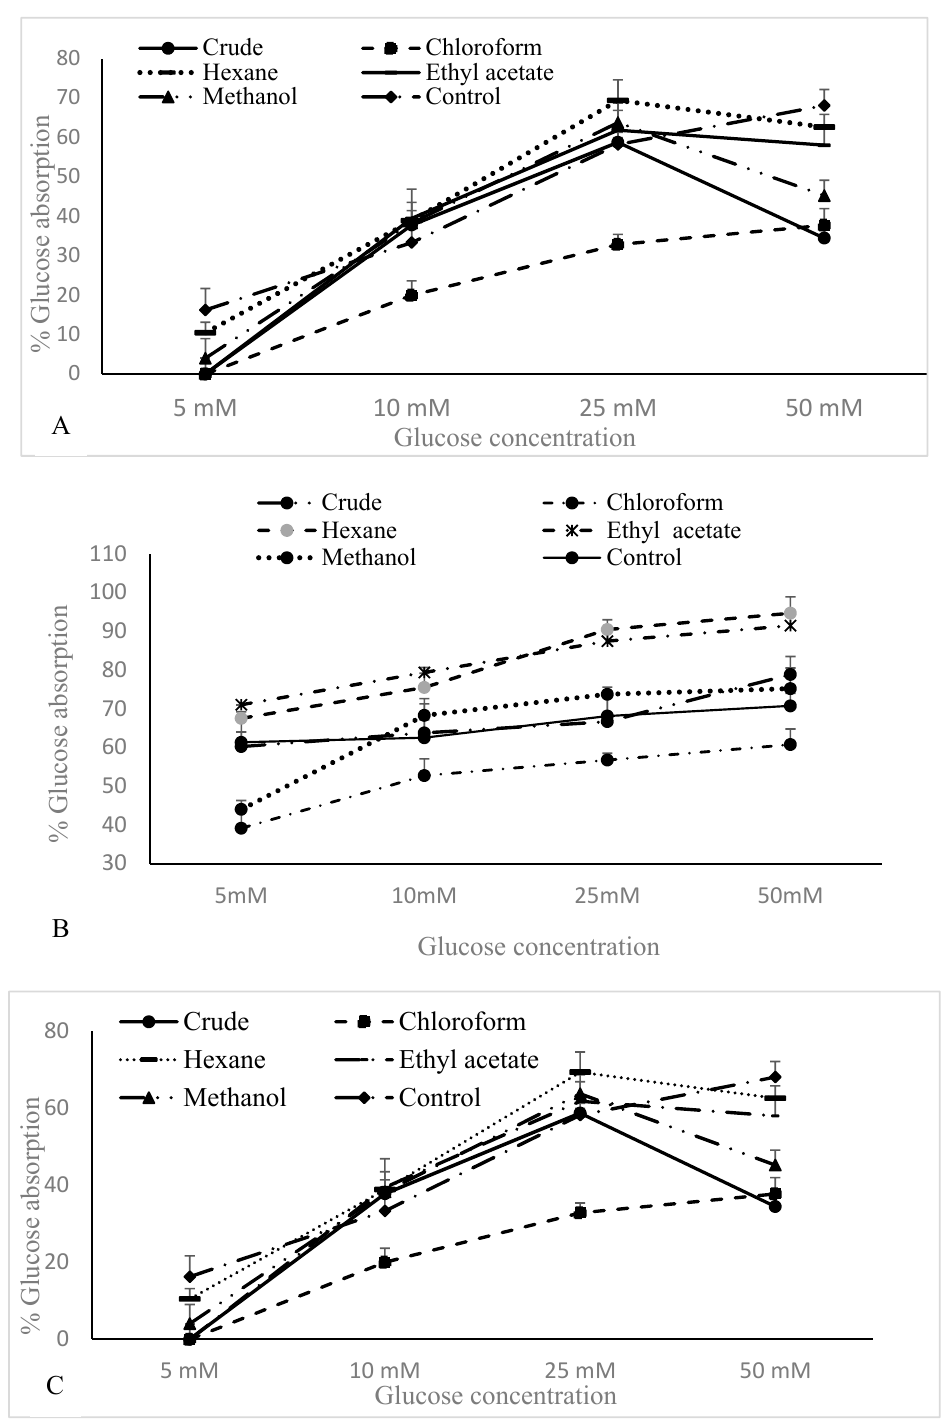
Figure 2. Percentage glucose absorption of crude aqueous extract of N. abor-tristis flowers, the fractions, and acarbose (control) at 1.5 mg/mL ( A ), 3 mg/mL ( B ), and 5 mg/mL ( C ) with different concentrations of glucose. Values are the mean ± SD of triplicate determination.